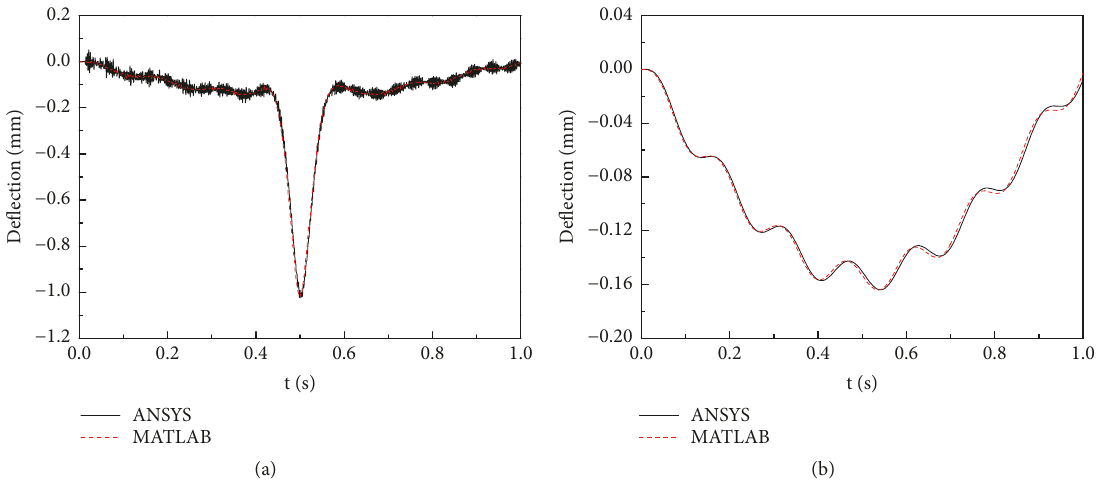
Figure 3: Mid-span deflection time-historyfor double simply supported rail-bridge system with load moving speed v = 32 m/s: (a) firstbeam; (b) second beam.